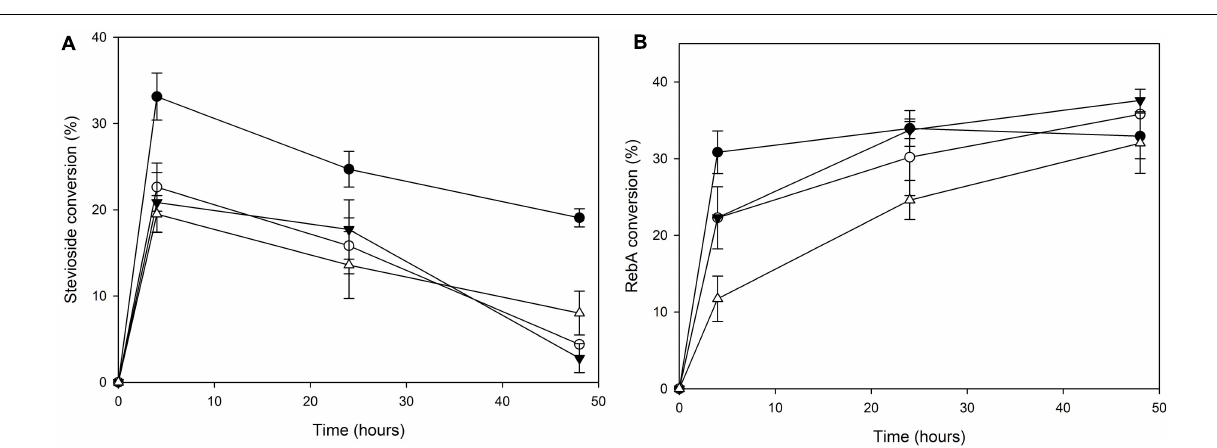
FIGURE 3 | Conversion of different concentrations of (A) stevioside and (B) RebA by Tt bGal1. Black circles : 2.5 g L − 1 glycoside, white circles : 5 g L − 1 glycoside, black inverted triangles : 7.5 g L − 1 glycoside, white triangles : 10 g L − 1